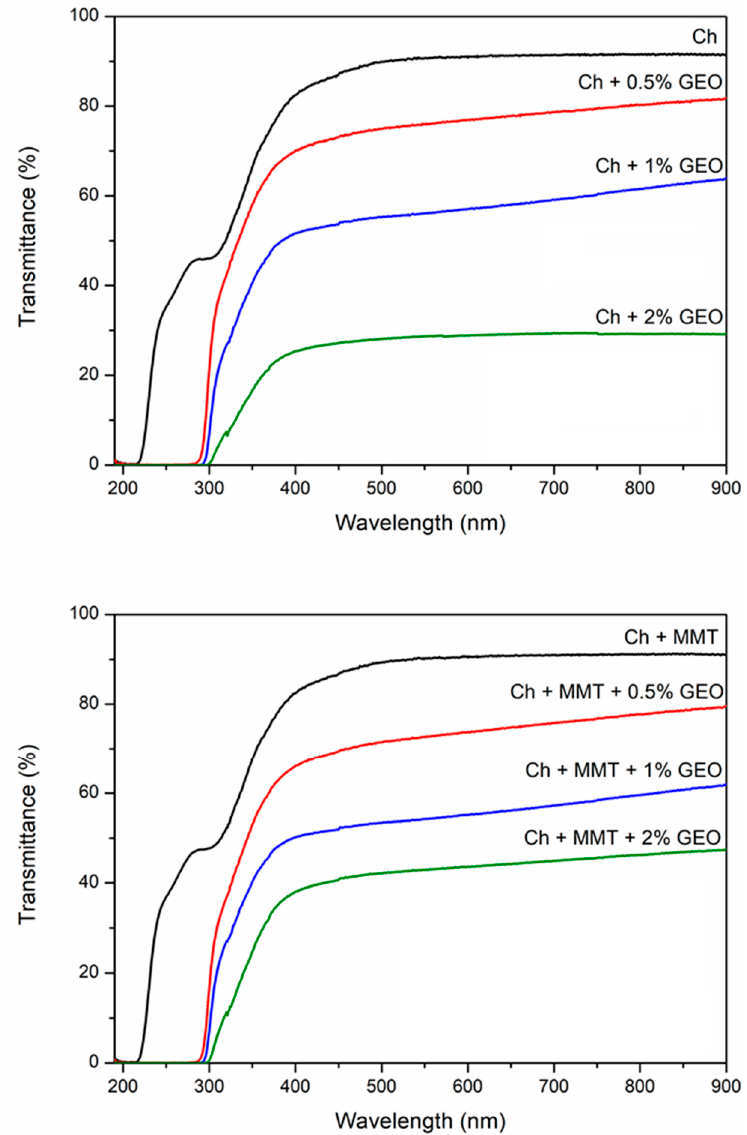
Figure 4. Film transparency of biopolymers produced. Ch, chitosan; MMT, sodium montmorillonite; GEO, ginger essential